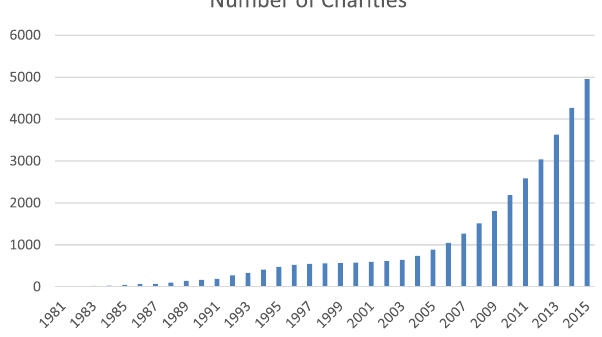
Figure 1: Growth trend of number of foundations in